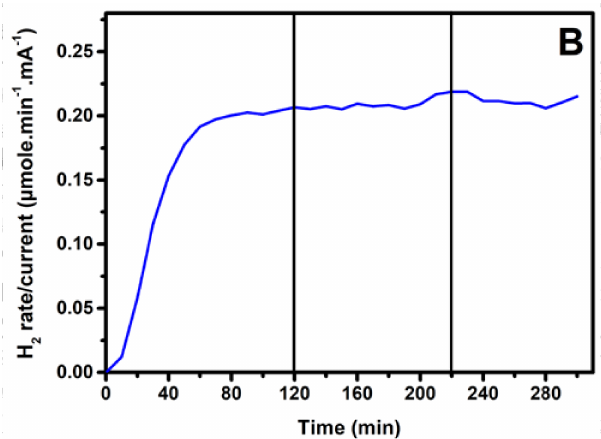
Figure 5. ( A ) Hydrogen production rates recorded by using the same photoanode and three different counter electrodes: (1) carbon paper without electrocatalyst; (2) carbon paper and RGO; and (3) carbon paper and carbon black + Pt. ( B ) Plot of the hydrogen production rate (3) divided by the corresponding current. The vertical lines show the times when the applied bias was changed: 0.5 V → 1.0 V → 1.5 V vs.